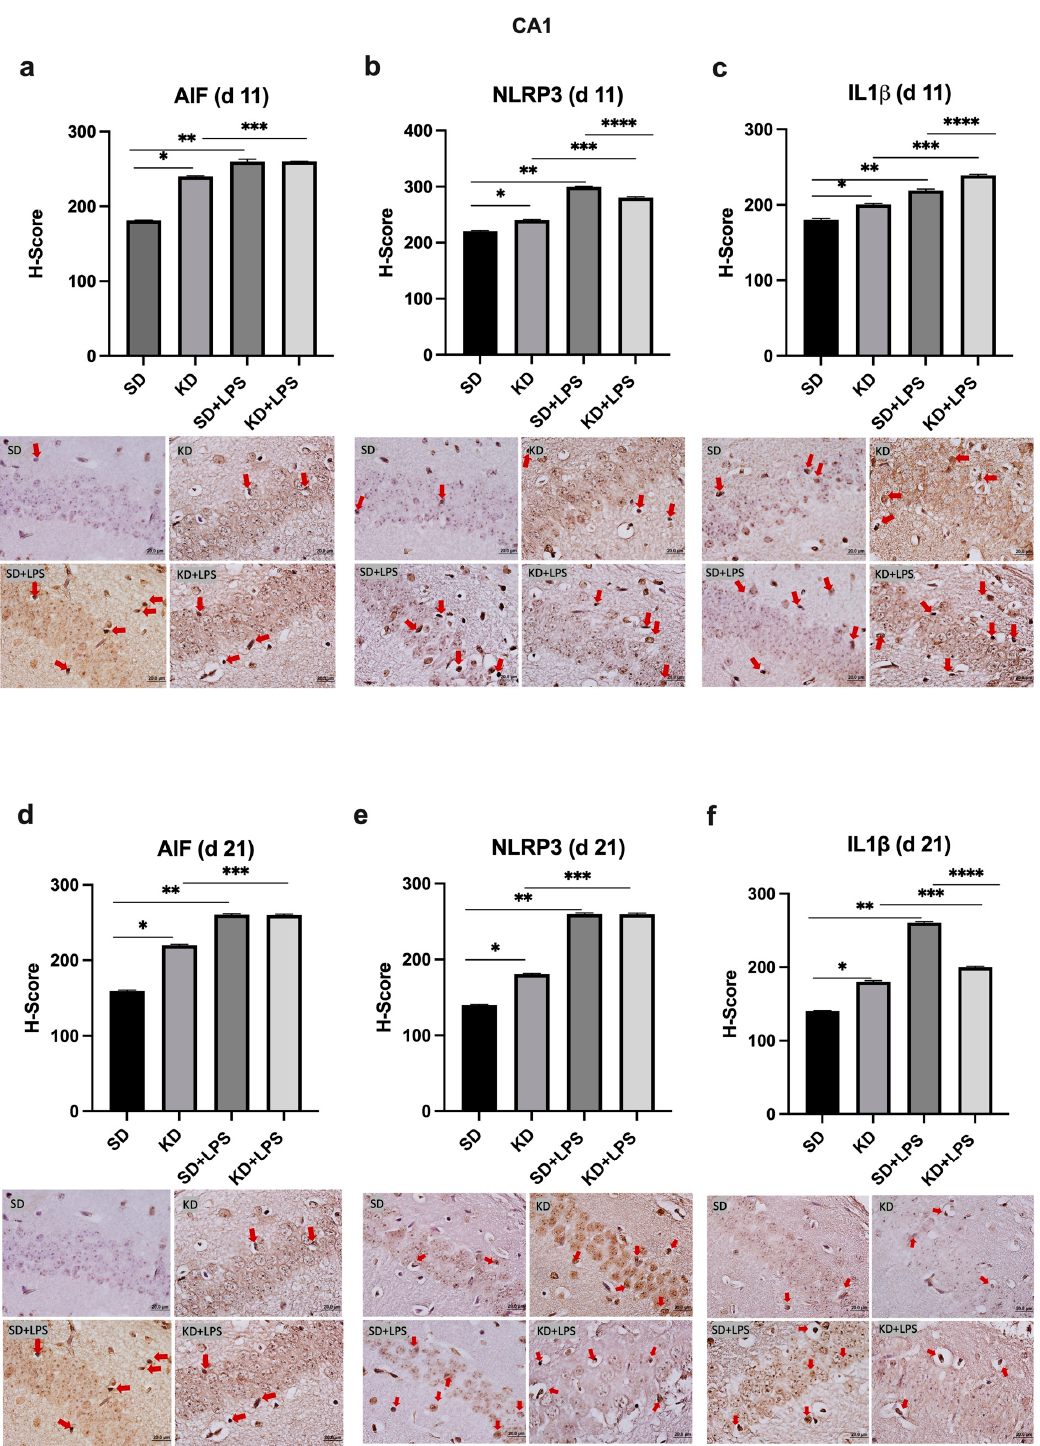
Figure 5. Immunohistochemical H-scoring and staining of the CA1 region of the hippocampus